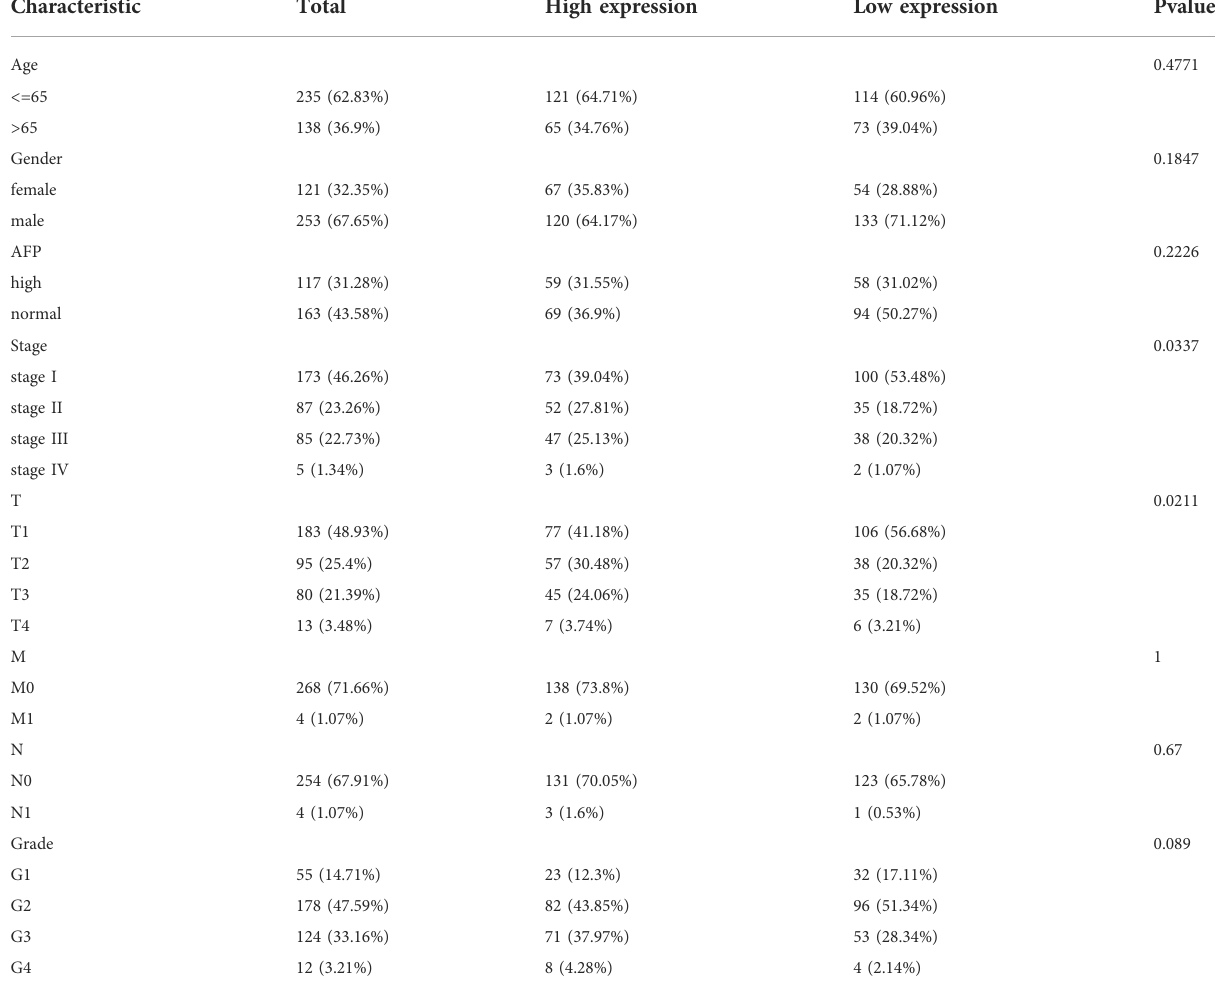
TABLE 1 Correlations between the RAB6B expression and clinical characteristics of patients with HCC from the TCGA.